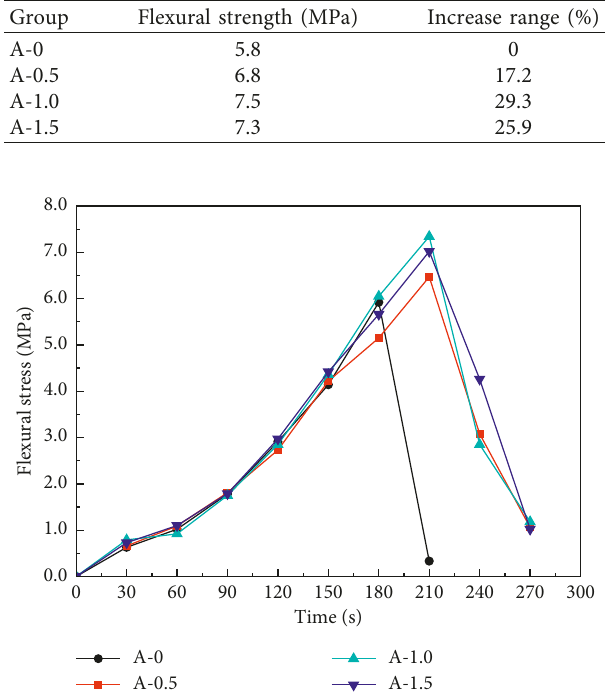
Figure 6: Relationship between flexural stress and time.